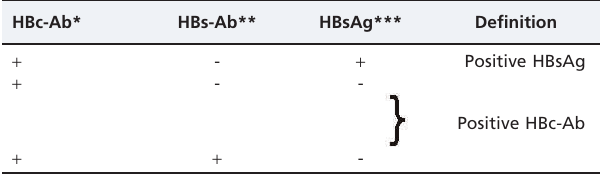
Table 1 - Definitions of HBV serologic profiles –